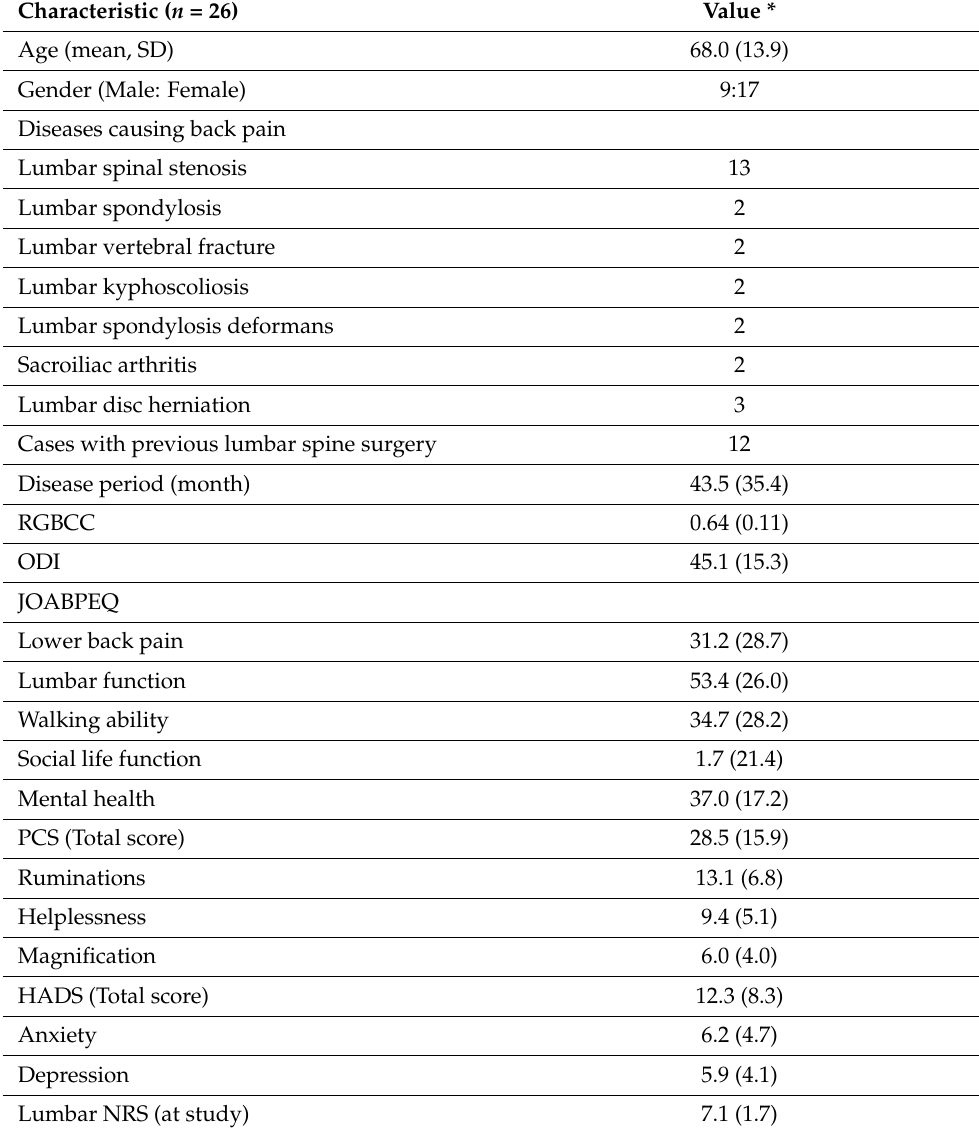
Table 2. Demographics and clinical characteristics of chronic lower back pain